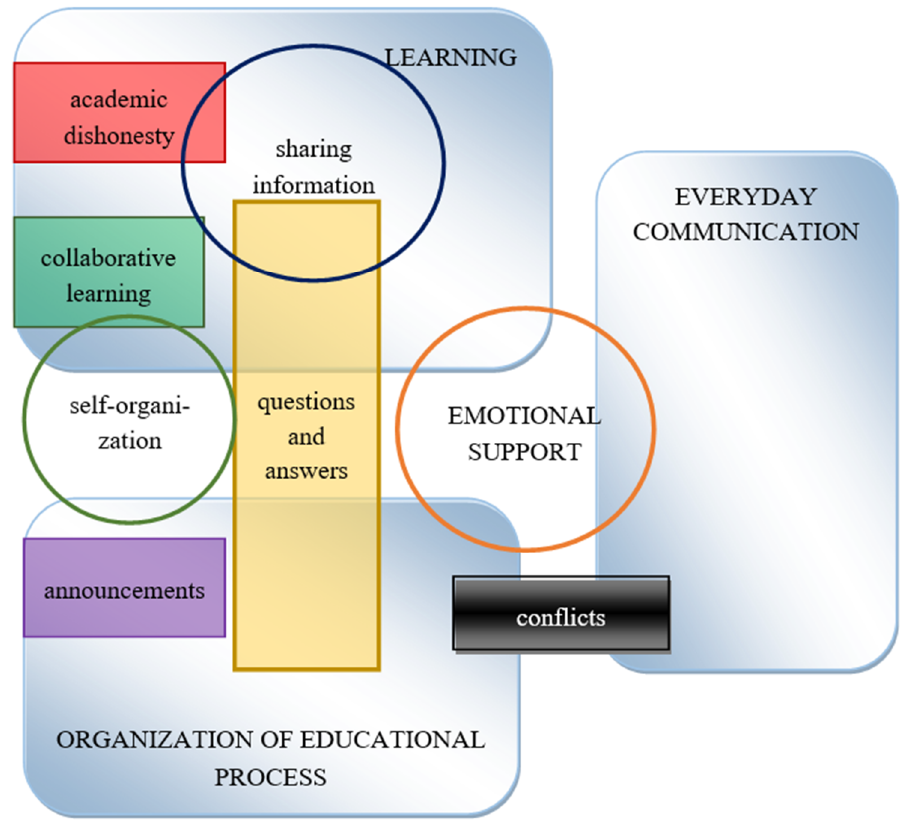
Figure 1. The main content of student conversations.